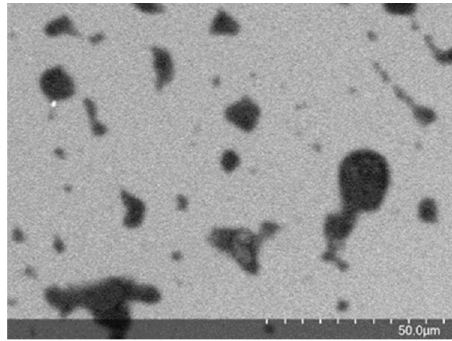
Figure 1. SEM image of OEO-NC-GL at 50 μm.